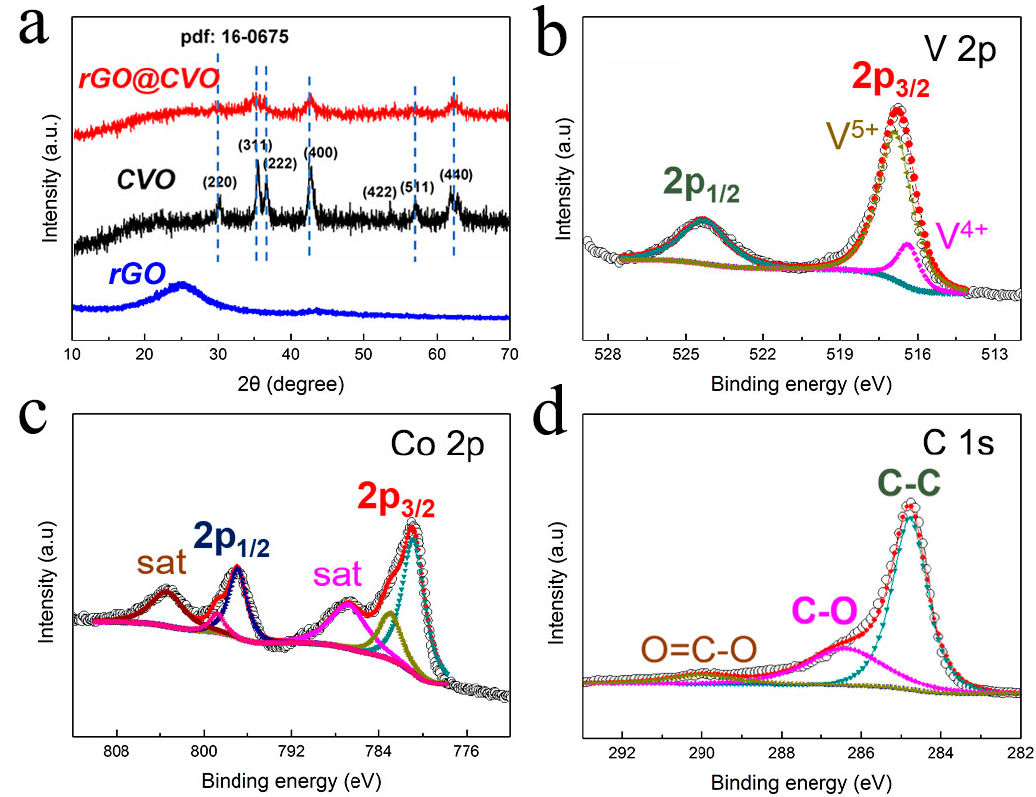
Figure 1. ( a ) XRD patterns of the CVO, rGO@CVO and rGO. XPS spectra of ( b ) V, ( c ) Co and ( d ) C of the rGO@CVO composite, respectively.